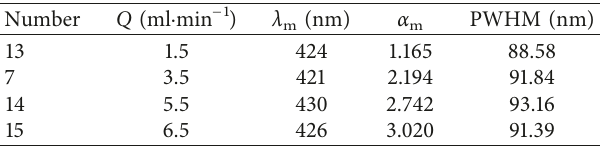
Table 4: Test results of AgNPs synthesized under different inlet flow